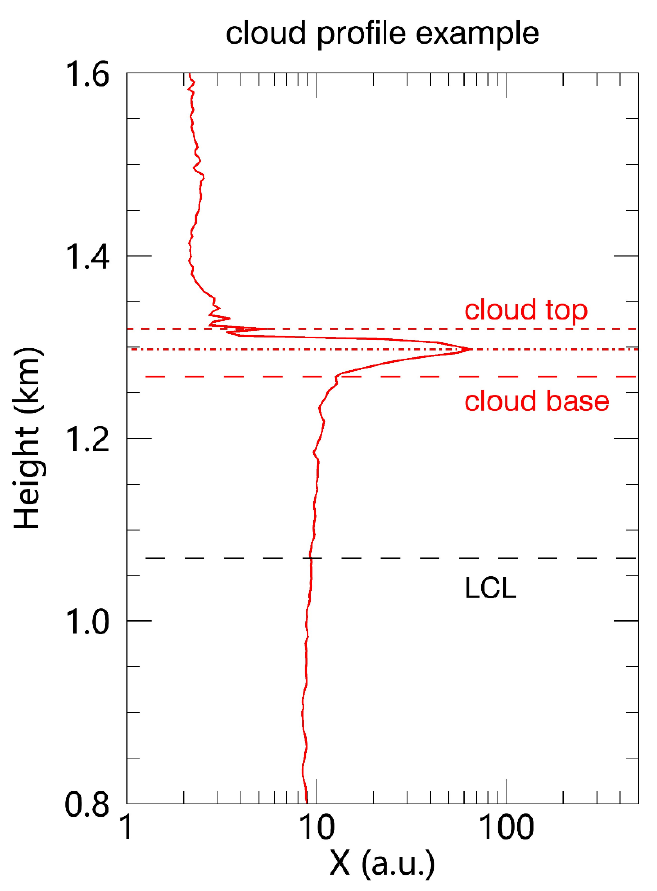
Figure 1. A plot of 1 min polarization lidar range-squared-corrected signal X profile observed at 1125 LT on 09 August 2019. The lifting condensation level (LCL), cloud base height, cloud peak height, and cloud top height are shown, respectively, by the black long dash, red long dash, red dash-dotted, and red short dash lines. The LCL is calculated based on Equation (1) in Section 2.2.2.